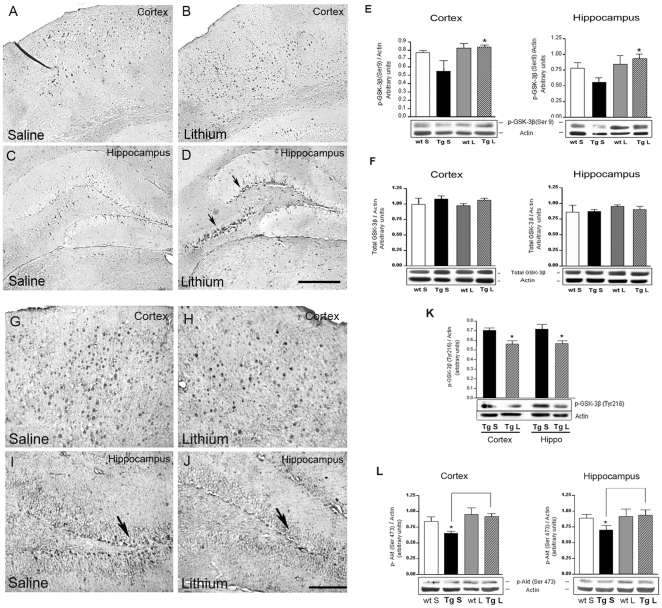
Effect of lithium treatment on the expression of GSK-3β isoforms and pAkt(Ser473) in the 3-month-old TgCRND8 mouse brain.A–D: representative photomicrographs of p-GSK-3β(Ser9) immunoreactivity in the cortex and hippocampus of saline (A,C)- and lithium (B,D)-treated TgCRND8 mice showing an increased p-GSK-3β(Ser9) immunoreactivity in the deep layers of the parietal neocortex (B) and in the hippocampus (D) of the lithium group compared to the saline group. Arrows in D indicate the p-GSK-3β(Ser9) immunoreactivity in the CA3 and dentate gyrus of the hippocampus. Scale bar: 100 µm (A–D). E and F: qualitative Western blotting and densitometric analysis of p-GSK-3β(Ser9) and total GSK-3β bands, respectively. β-actin serves as a protein loading control. Statistics indicate a significant increase of p-GSK-3β (Ser9) levels in the neocortex and hippocampus of lithium-treated 3-month-old Tg mice compared with the age-matched controls and no differences in the total GSK-3β expression among the groups. *P<0.05, vs saline-treated Tg. Two-way ANOVA plus Bonferroni's post hoc test. G–J: representative photomicrographs of active GSK-3β immunoreactivity in the cortex and dentate gyrus of the hippocampus of saline (G,I)- and lithium (H,J)-treated TgCRND8 mice. Note fewer active GSK-3β positive cells in the parietal neocortex (H) and hippocampus (J) of the lithium group compared to the saline group. Arrows in I and J indicate the GSK-3β immunoreactivity in the dentate gyrus. Scale bar:100 µm (G–J). K: qualitative Western blotting and densitometric analysis of p-GSK-3β(Tyr216) protein levels in the cortex and hippocampus of saline- and lithium-treated TgCRND8 mice. Statistics indicate a significant reduction of p-GSK-3β(Tyr216) levels in the cortex and hippocampus of lithium-treated 3-month-old Tg mice compared with the age-matched controls. Student's t test: *P<0.05, lithium-treated Tg vs saline-treated Tg mice. (L) qualitative Western blotting and densitometric analysis of pAkt(Ser473) in the cortex and hippocampus of saline- and lithium-treated wt and Tg mice. Statistics indicate a slight but significant increase in the levels of this kinase by lithium treatment in the Tg mice. Two-way ANOVA plus Bonferroni's post hoc test: *P<0.05, saline-treated Tg vs lithium-treated Tg mice. Data are presented as mean ± S.E.M. β-actin serves as a protein loading control. Ctx: Cortex; Hippo: hippocampus, S = saline, L = lithium, Tg: TgCRND8.